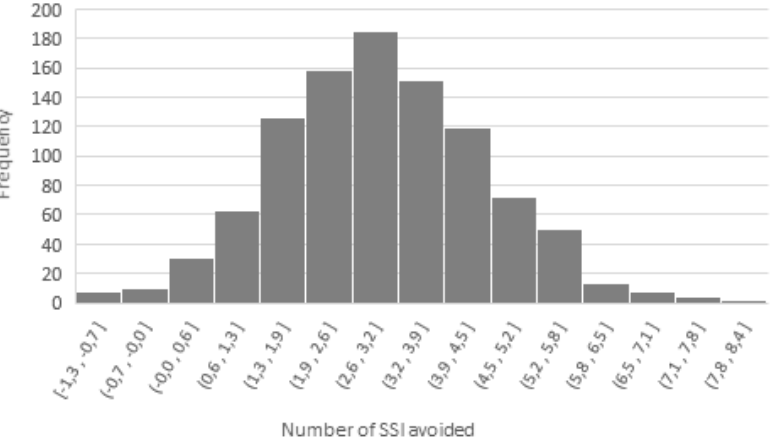
Figure 2. Histogram of the number of avoided SSI episodes according the probabilistic sensitivity analysis. Abbreviations: SSI, surgical site infection.